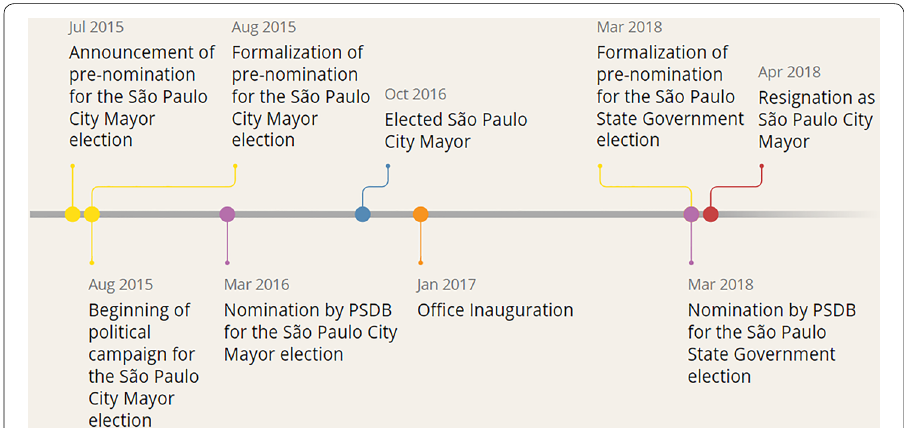
Fig. 1 Time line of the João Dória Jr. public figure (Source: prepared by the